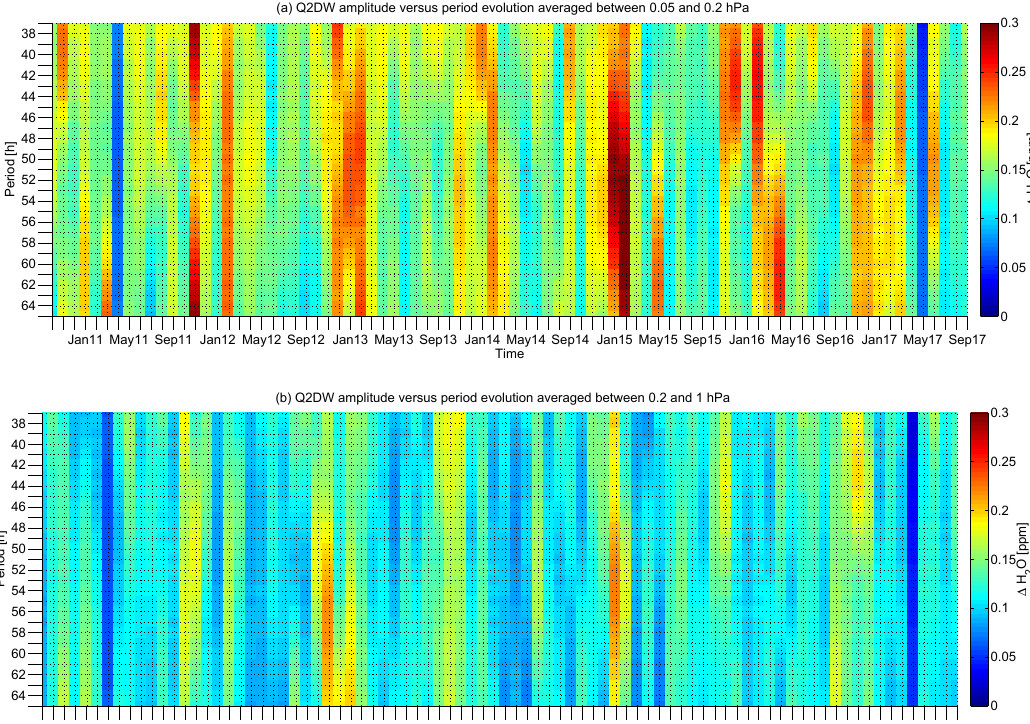
Figure 7. Matrix plots of the temporal evolution of monthly mean Q2DW amplitudes in units of ppm with a dependency on the period (38–64h). The top plot shows the pressure-layer-averaged wave amplitudes between 0 . 05 and 0 . 2hPa, while the bottom plot shows those between 0 . 2 and